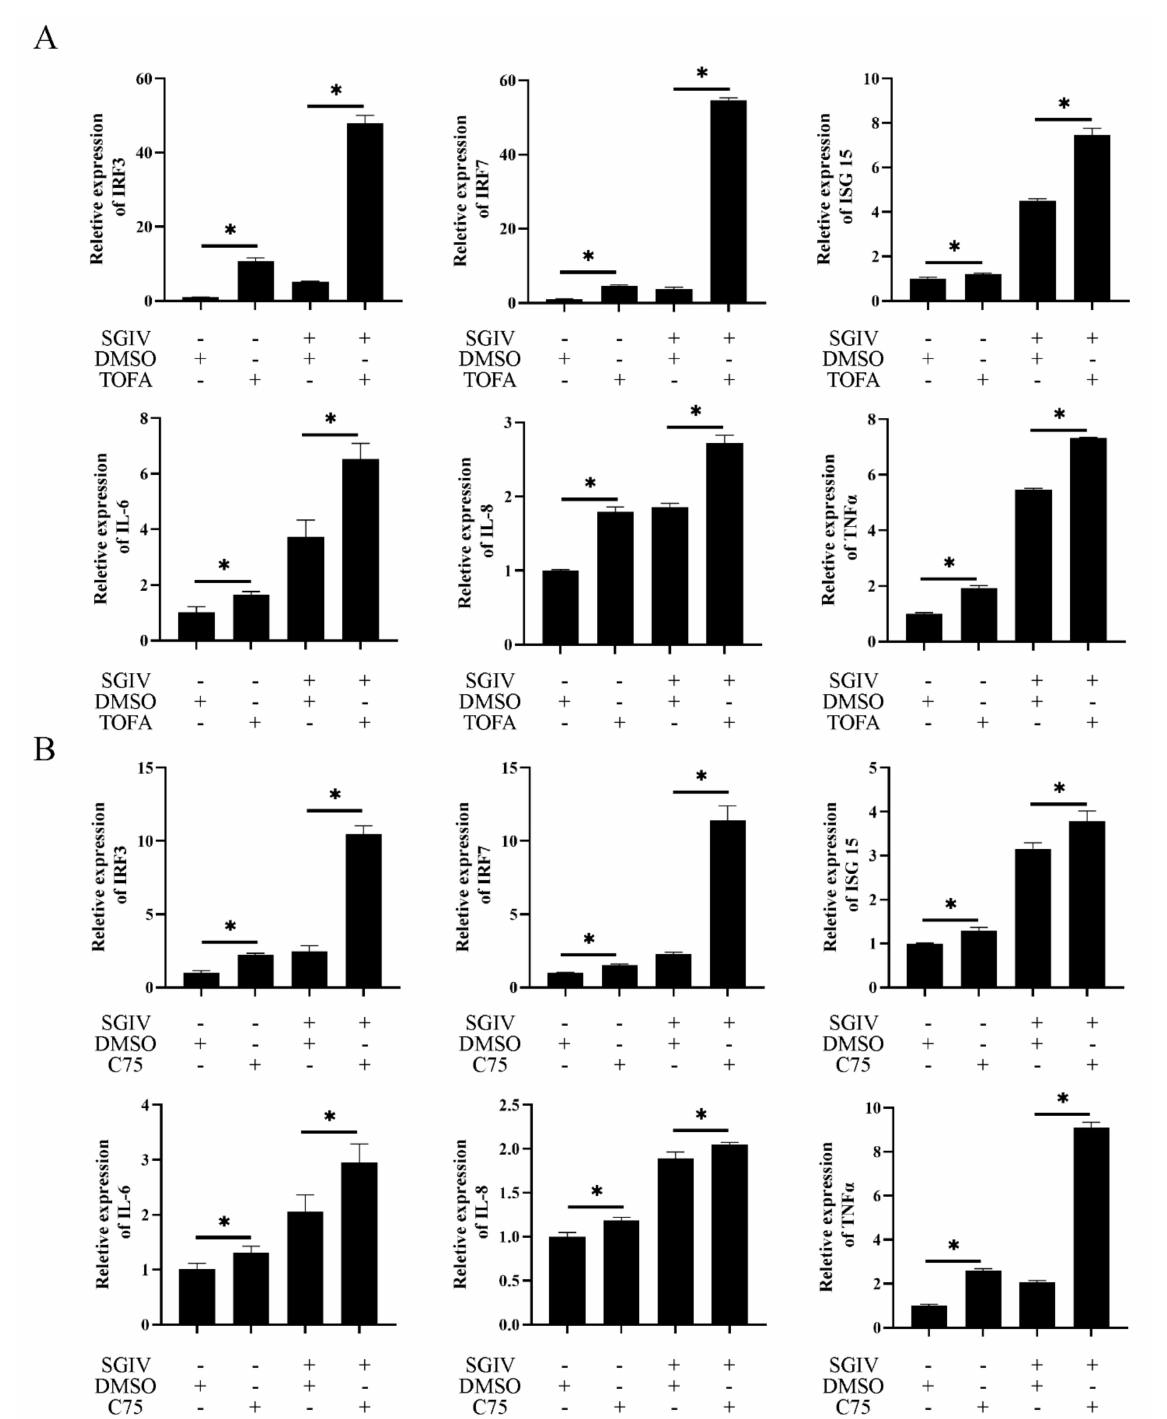
Figure 8. Inhibition of de novo fatty acid biosynthesis increases the IFN immune and inflammatory response. GS cells were preincubated with DMSO, TOFA and C75, and then infected with Mock/SGIV. The IFN-related genes, including IRF3, IRF7 and ISG15, were markedly upregulated ( A ), including in proinflammatory factors such as IL-6, IL-8 and TNF α ( B ). n = 3, data are expressed as means ± SD. * indicates p <